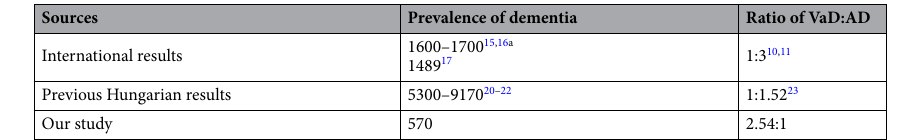
Table 4. Estimation of prevalence of dementia and ratio of VaD and AD according to different sources. We summarized the prevalence of dementia from the literature. It is complicated to compare the results because the examined samples. The data shows number of patients per 100,000 inhabitants. a Limited data are available from Hungary therefore we had to use estimations from the